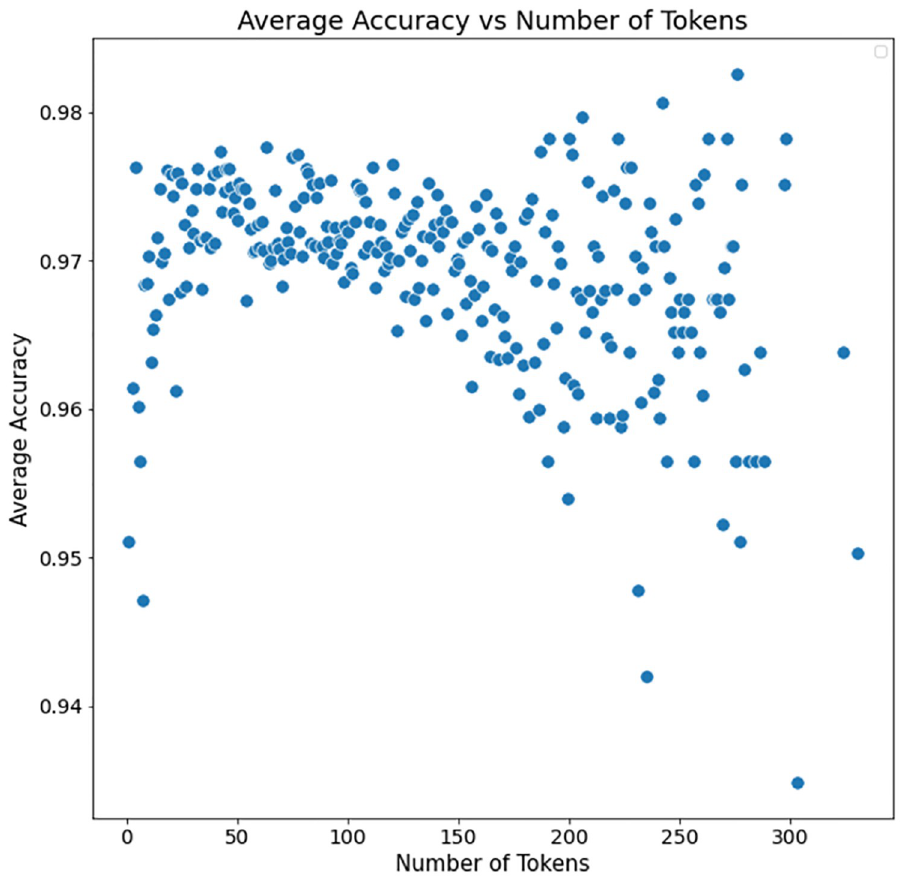
Fig 3. The average accuracy (across all specialties) for the highest performing classifiers (when optimized for F 1 Score) by different lengths of the referral notes (as measured by number of tokens). We observe that notes with few tokens have poor accuracy. On the other hand, notes with many tokens are likely have a noisy signal (containing more keywords belonging to other specialties), thus resulting in poor